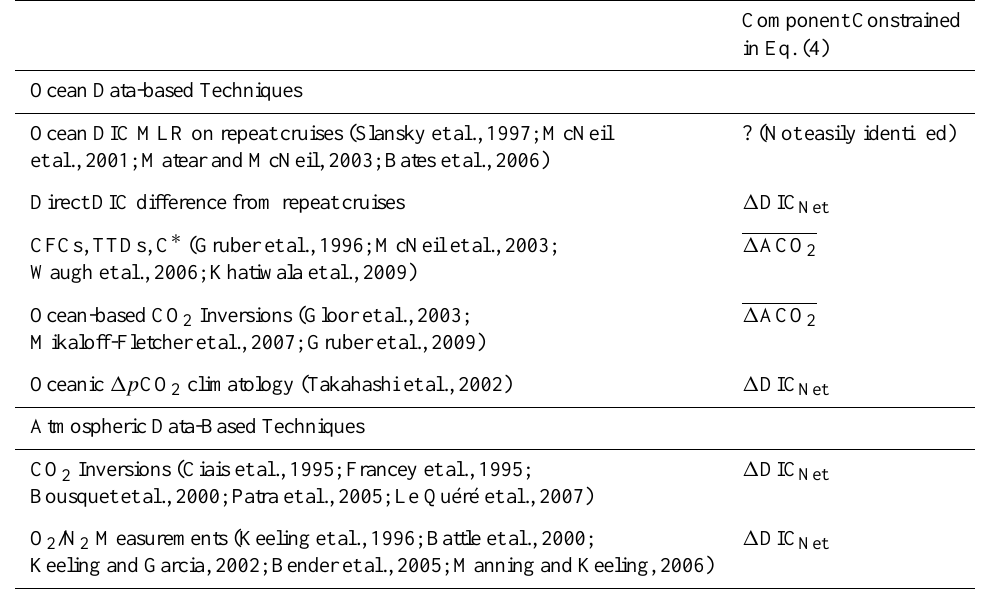
Component Constrained in Eq. (4)